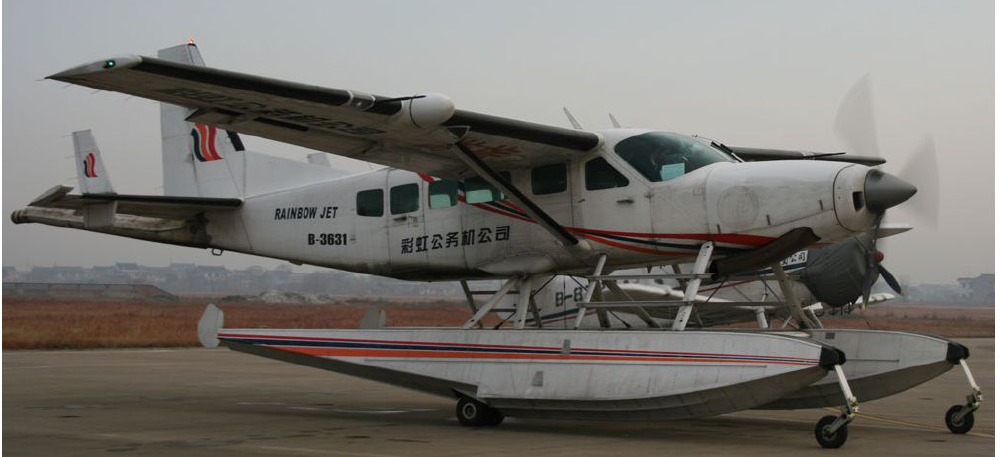
Figure 5. The single engine small aircraft Cessna 208B Grand Caravan with the engine running (Taken in Shandong in April